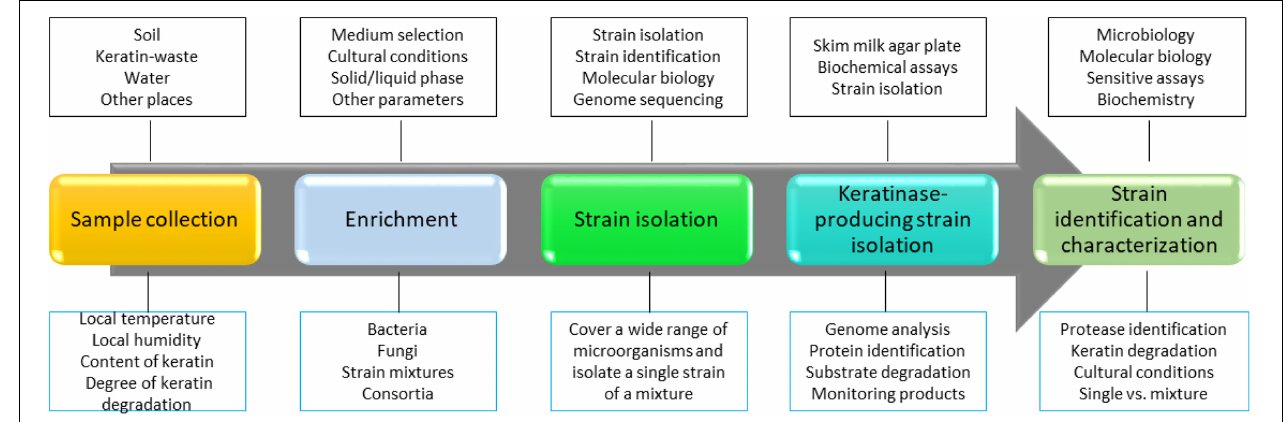
FIGURE 1 | A strategy to screen keratinase-producing microorganisms. In this strategy, a method to identify keratinase-producing strain is critical. Molecular biology, bioinformatics, biochemistry, and sensitive analytical methods such as MS are critical in the screening. In addition, as keratin degradation is a complicated step, sample isolation and enriching steps are important to make sure that the desired strains are sustained. Many keratinase-producing strains have been isolated and identified from the environment (Nnolim and Nwodo,